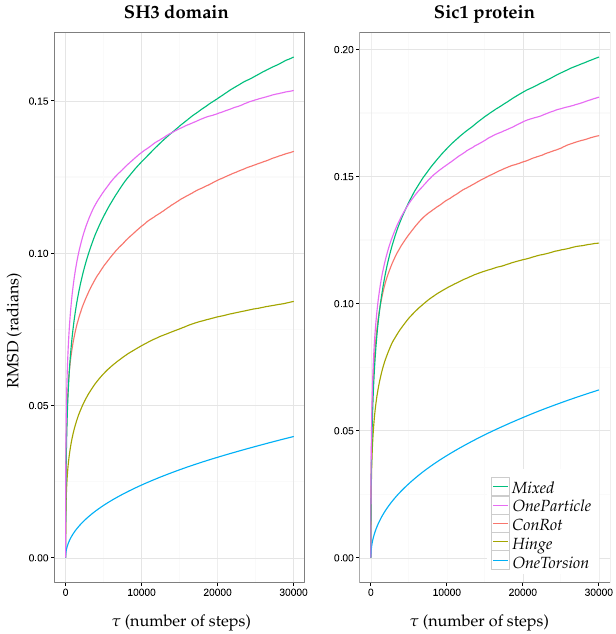
Figure 4. Plots of the function rmsd ( τ ) for each move class during MC runs for the SH3 domain (left) and the Sic1 protein (right).